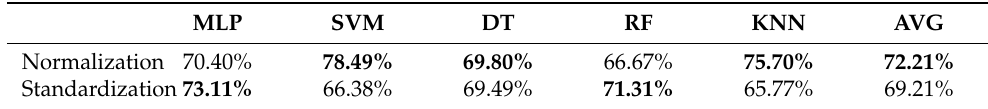
Table A1. The average of the accuracy obtained through eight experiments after feature scaling using normalization and